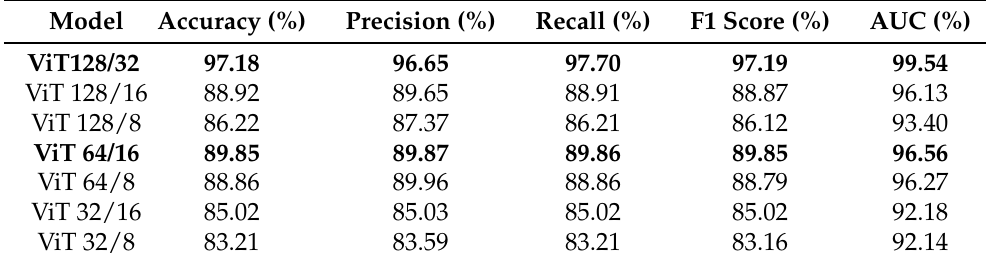
Table 4. Performance of the ViT variants.